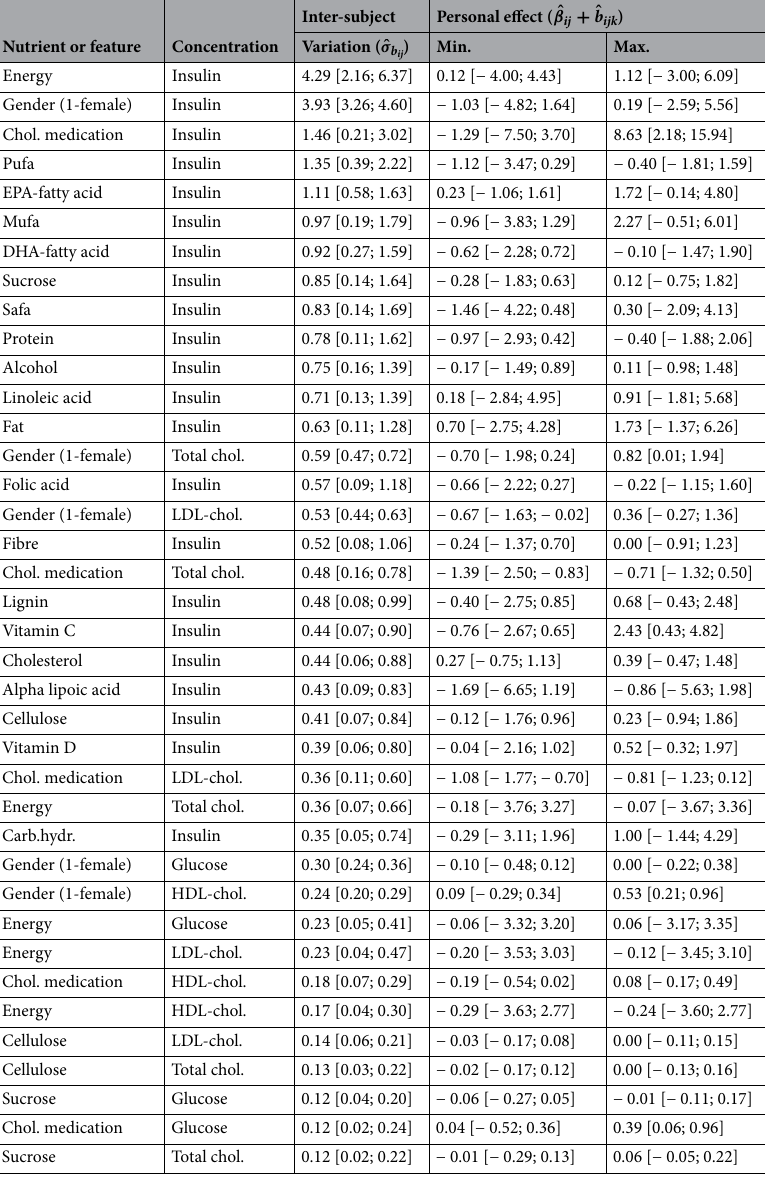
Table 3. Those effects of nutrition that have highest variations between the studied subjects. These 38 (of all 110) effects from nutrients and other modeled features ( j = 1, . . . , 22 ) to blood concentrations ( i = 1, . . . , 5 ) had the highest variations between the studied subjects (k = 1,...,106). The estimated standard deviation ( ˆ σ b of personal effects varies from 4.29 to 0.02, and this table is sorted to include the most varying effects with the standard deviation over 0.10. The table also shows the minimum and maximum of the personally adjusted ˆ β + ˆ b effects ( ij ijk ) with 90%-credible